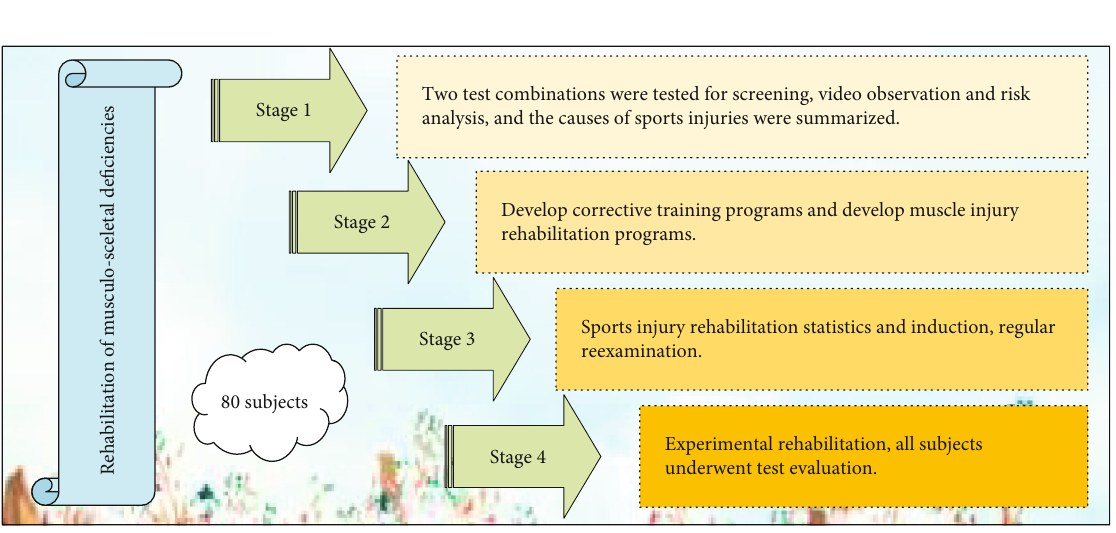
Figure 1: Rehabilitation measures for sports injury.